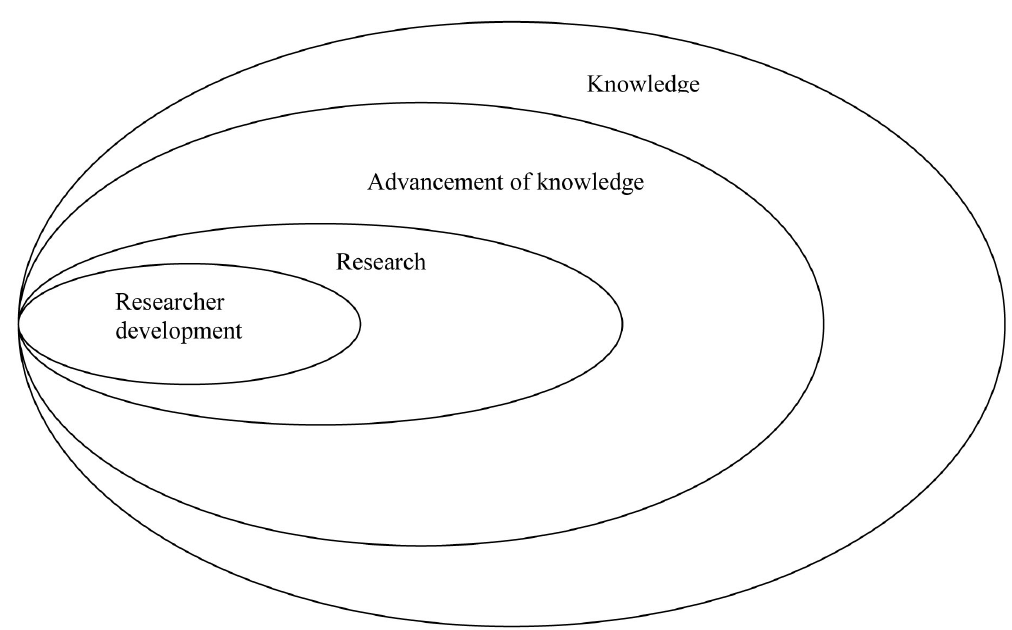
Figure 1: Researcher development within the contexts of research, the advancement of knowledge and